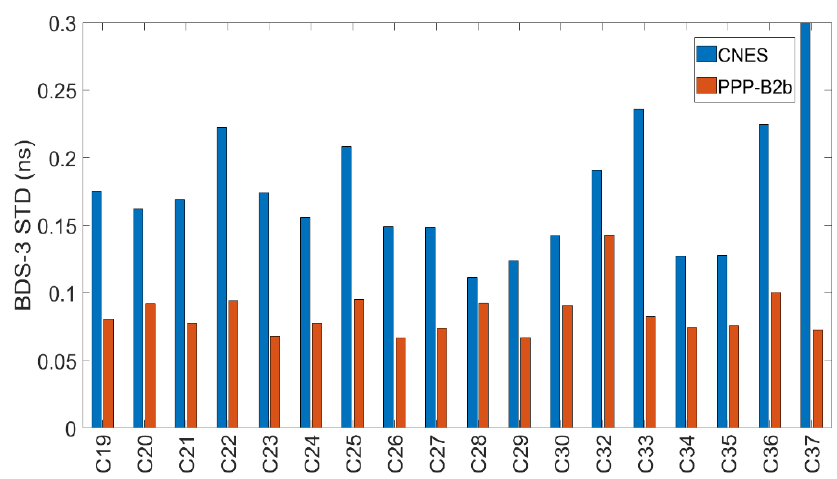
Figure 8. STD values of BDS-3 clock offset errors for the PPP-B2b and CNES products.